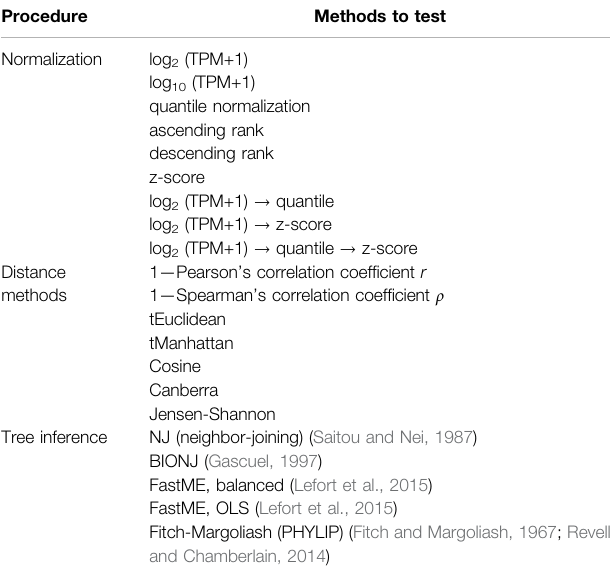
TABLE 1 | Derivedness tree construction method combinations for